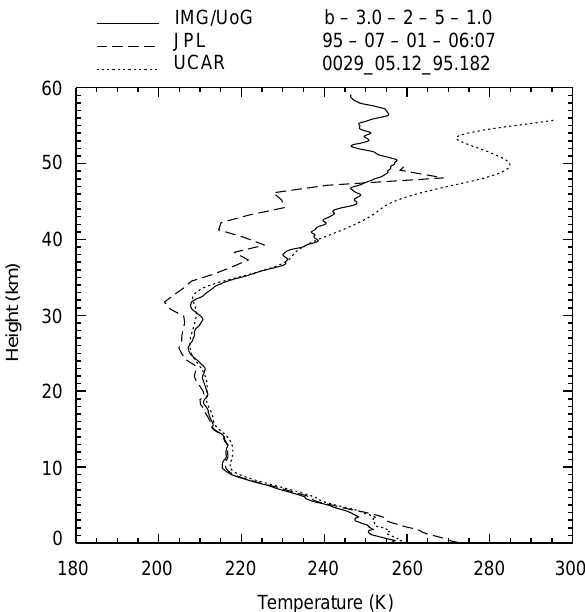
Fig. 7. Same as Fig. 6 but for the occultation event placed at 53 (cid:14) S, 100 (cid:14) E on 1 July 1995, 6:07 UT